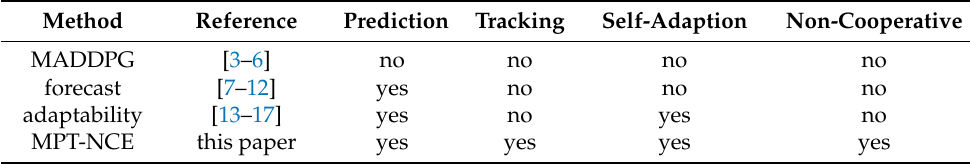
Table 1. Comparison of the work in this paper and related